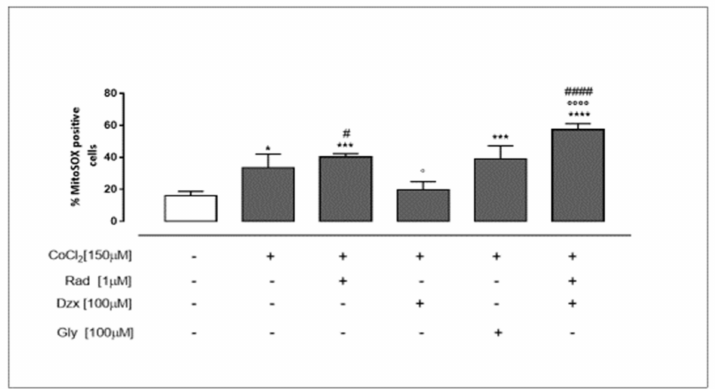
Figure 2. Mitochondrial Cx43 and mitochondrial K ATP channels are involved in the reduction of CoCl 2 -induced superoxide production. H9c2 cells were treated for 3 h with CoCl 2 (150 µ M); rad (1 µ M), dzx (100 µ M) and gly (100 µ M) were added 30 min before CoCl 2 administration. Mitochon- drial superoxide production was evaluated by means of the probe MitoSOX Red by flow cytometry analysis. Results are expressed as mean ± S.E.M. of percentage of MitoSOX positive cells of at least three independent experiments, each performed in duplicate. Data were analysed by Bonferroni post-test. * p < 0.05,*** p < 0.001 and **** p < 0.0001 vs. untreated cells; ◦ p < 0.05 and ◦◦◦◦ p < 0.0001 vs. CoCl 2 -treated cell; # p < 0.05 and #### p < 0.0001 vs. CoCl 2 and dzx co-treated cell.